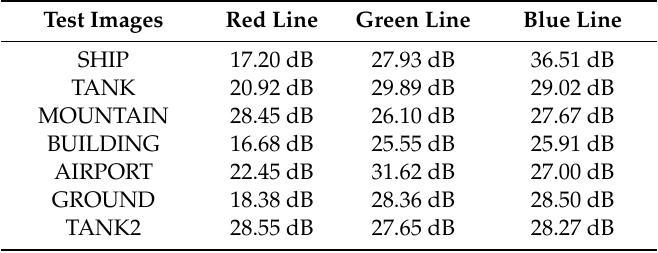
Table 1. PSNR result of red, green, and blue line on original MWIR images and converted MWIR image of Figure